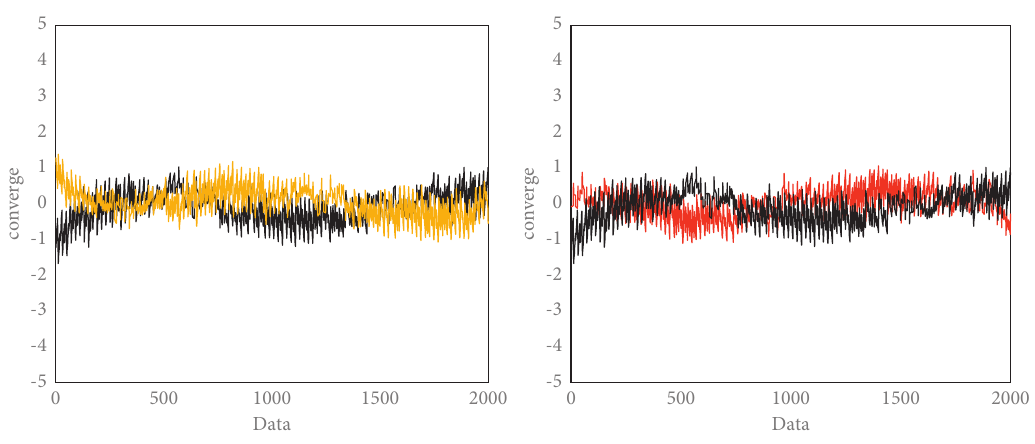
Figure 7: Convergence.